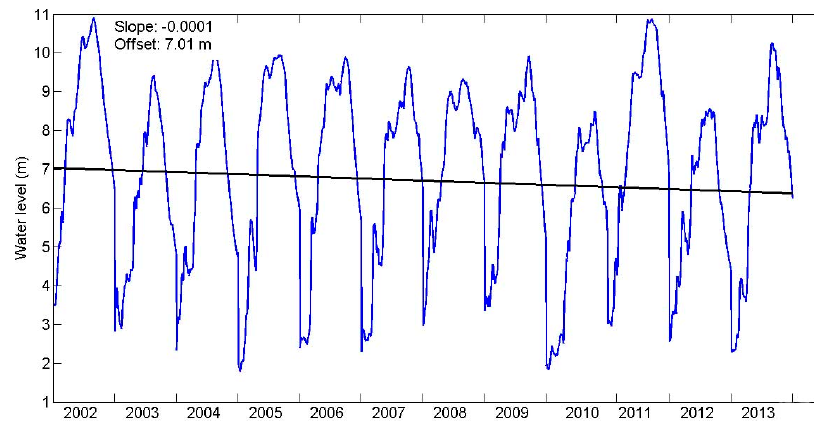
Figure 7. Water level trend at the Bassac Chamtomuk station during the rainy season (June to November).